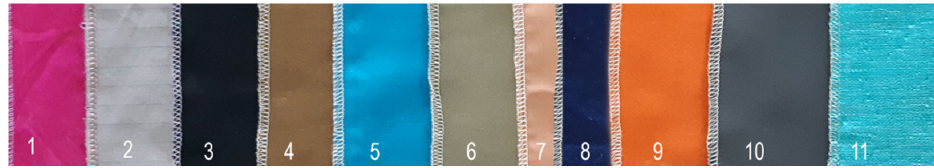
Figure 8. Textile samples of different material composition.